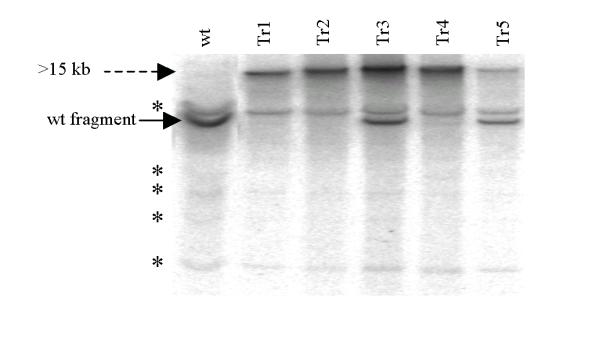
Southern blot analysis of StuI-digested DNAs of wild-type Nectria haematococca and five transformants. Total genomic DNAs of wild-type (wt) Nectria haematococca and five s transformants (Tr1-Tr5) that were obtained after co-transformation of wt with psec3-s1 plasmid and pBC-Hygro vector, and probed with psec3-s1. All the transformants share a large band (>15 kb), absent from wild type. Tr3 and Tr5 contain both the wild type and the s1 allele. The faint bands noted * correspond to repeated sequences homologous to those present at the Ses locus.